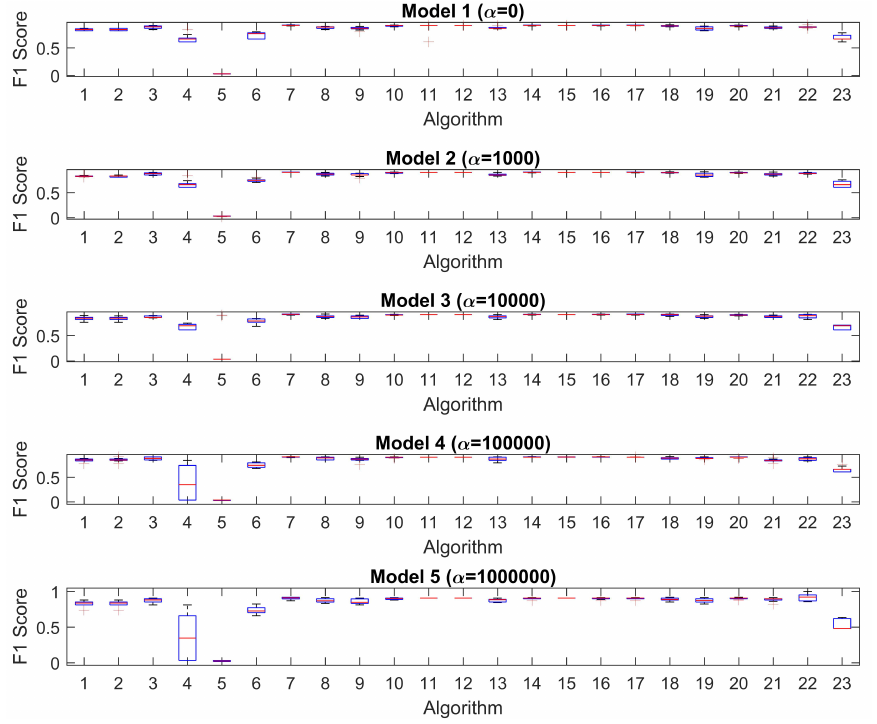
Figure A6. Numerical simulation Assumption 2. F1-score of various models after permutations in the numerical values of the mapping. The 23 algorithms are represented in the x -axis, and the accuracy is shown in the y